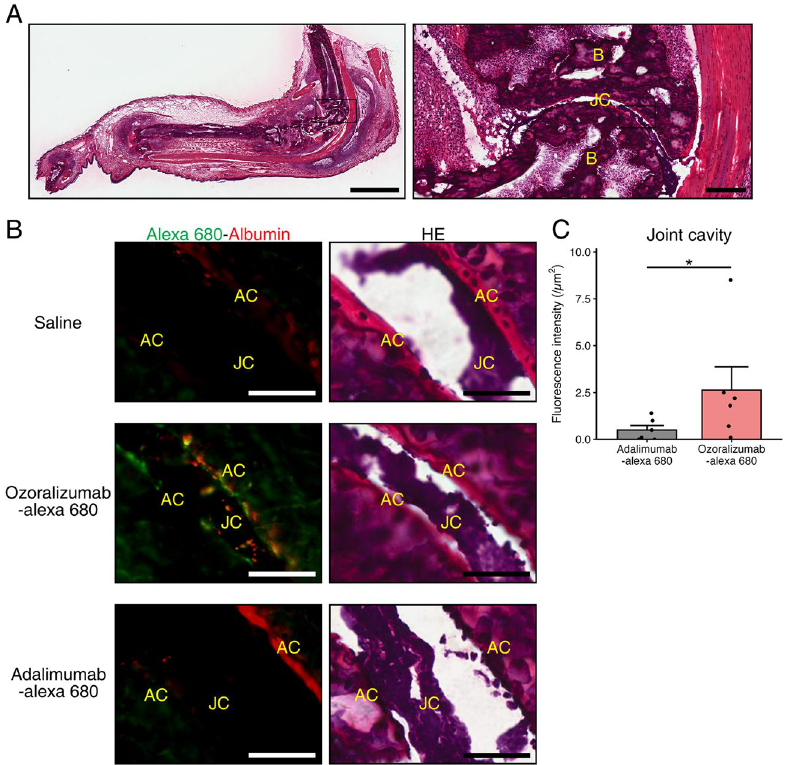
Figure 5. Localization of MSA and test articles in the talocrural joint. ( A ) Paws of the CIA mice were sectioned in the sagittal plane and stained with hematoxylin & eosin (HE). Scale bar: 2 mm (left), 200 µm (right). B: bone; JC: joint cavity. ( B ) At eight hours after a single subcutaneous injection of ozoralizumab-Alexa 680 and adalimumab-Alexa 680, immunohistochemistry was performed on sagittal sections of the talocrural joints using antibody against MSA. The green fluorescence represents the administered compounds labeled with Alexa 680 and red fluorescence represents albumin. Serial sections were stained with HE (right). Scale bar: 50 µm. AC: articular cartilage; JC: joint cavity. ( C ) The fluorescence value of Alexa 680 merged with the fluorescence of Alexa 488-labeled albumin antibody in immunohistochemistry sections of the joint cavity at eight hours after subcutaneous injection was analyzed. Dot plots represent each individual data and bars represent the means ± SEM. P values were calculated using the Wilcoxon rank sum test. * P <